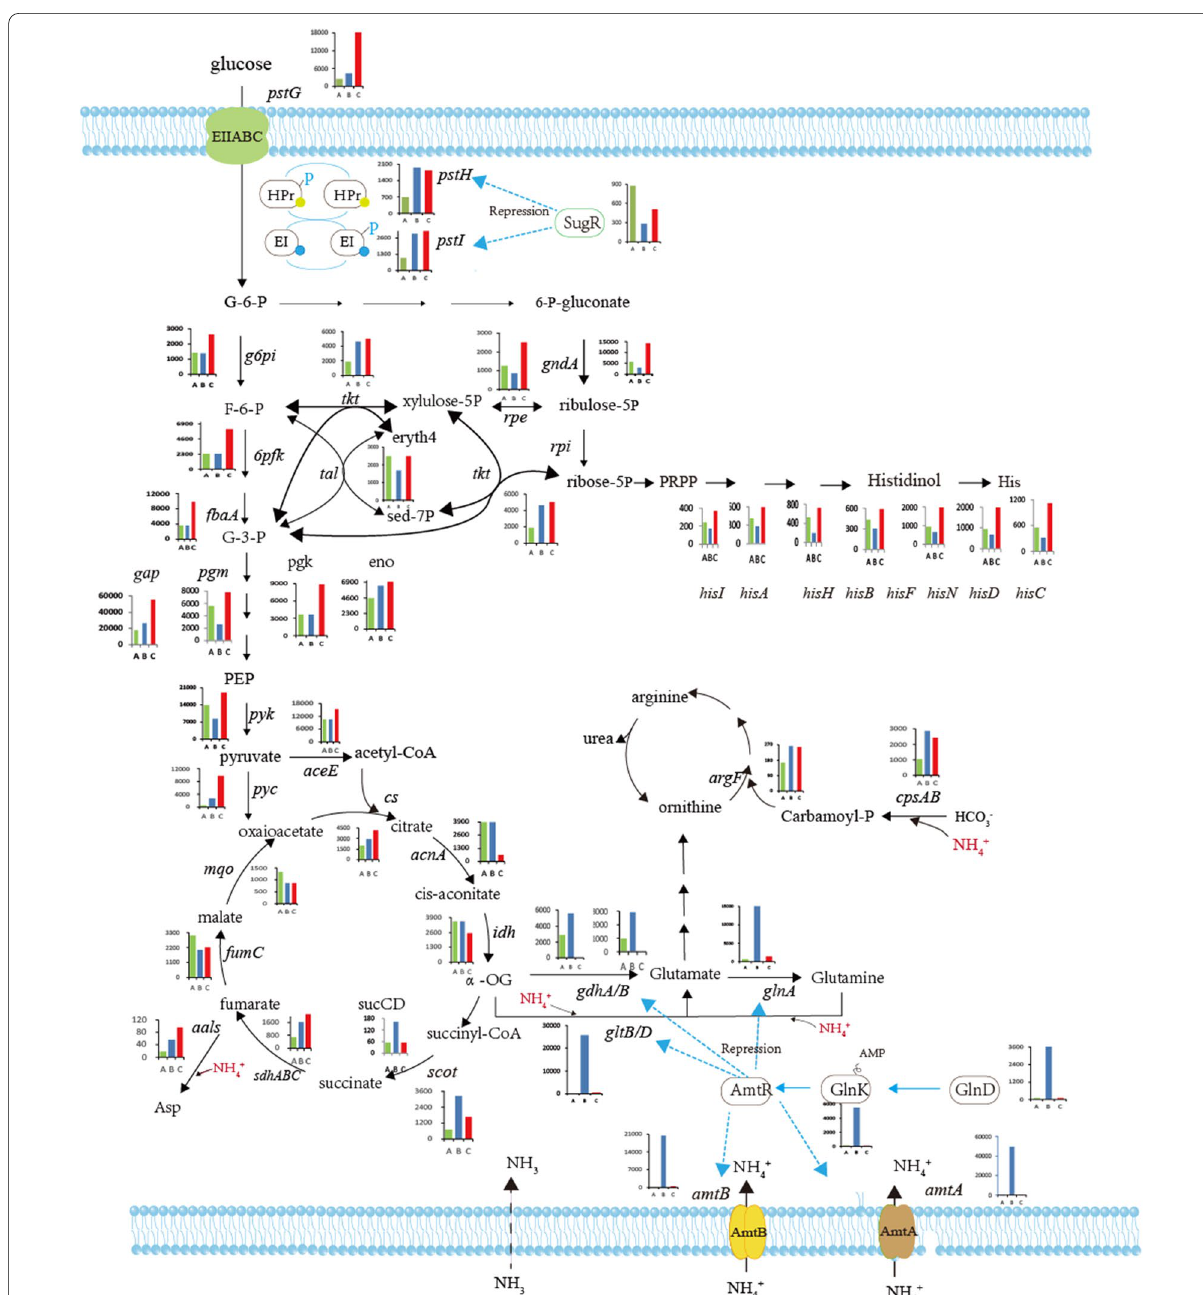
Fig. 4 Changes of expression of genes in different metabolic pathways of strains F1 and F5 grown with ammonium. Reactions of the central metabolism together with several biosynthesis pathways are shown here. Metabolites are abbreviated according to 13CFLUX2 (www. 13Cfl ux. net) and description of all genes has been given in Additional file 1: Table S5. The bar graph represents the FPKM value of the gene, and the numbers indicate the values of the expression levels (FPKM) (please see the Martials & Methods). The A , B , C from left to right are: C.glutamicum F343 (strain F1) with ammonium, C.glutamicum F343 (strain F1) with glutamine, C.glutamicum ∆gdhA∆gdhB (strain F5) with ammonium,